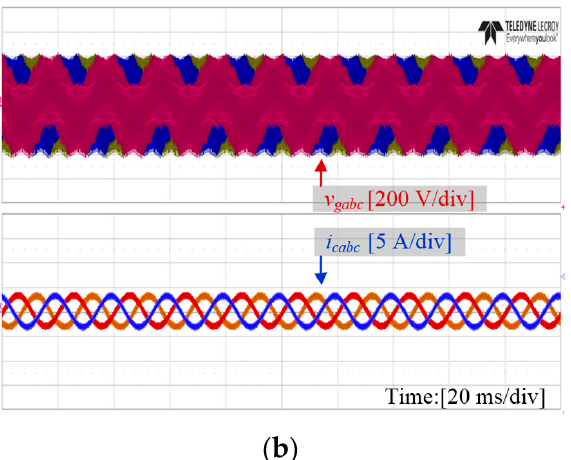
Figure 19. Experimental results of DSTATCOMs with and without the proposed control scheme: ( a ) overall view; ( b ) zoomed-in view with the proposed control scheme.